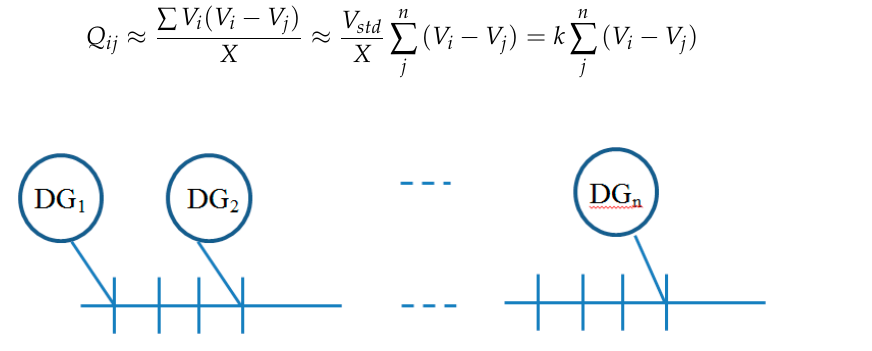
Figure 3. A multi-bus multi-DG microgrid.